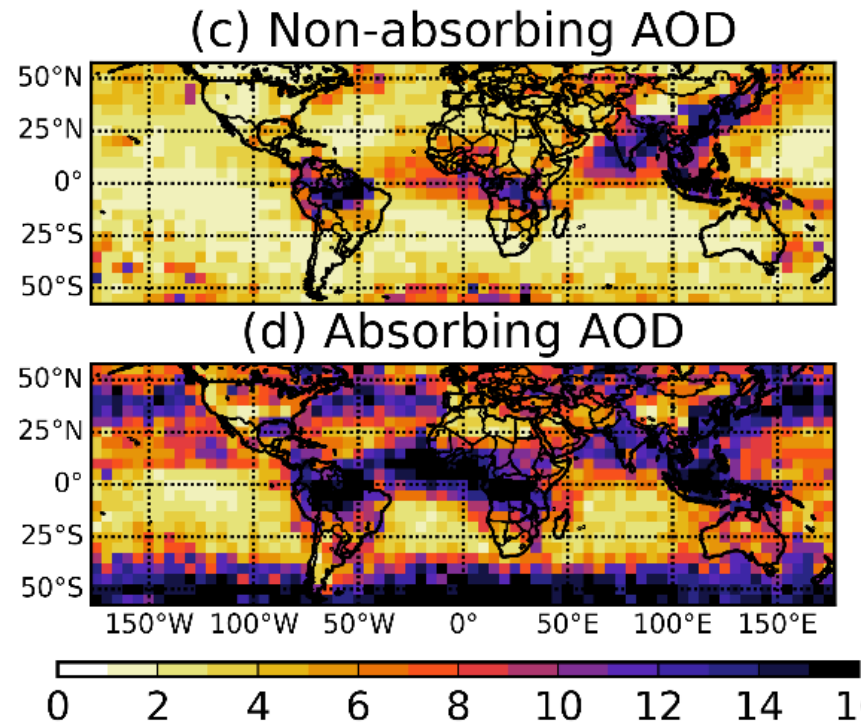
Figure A7. The minimum record lengths required to obtain stable seasonal climatology of ( a ) total, ( b ) nonspherical, ( c ) nonabsorbing, and ( d ) absorbing aerosol optical depths in Winter (December-January- February) within the predefined accuracy levels ( ± 0.01 AOD for ( a ), ± 0.004 for ( b ), and ± 0.005 for ( c ) and ( d